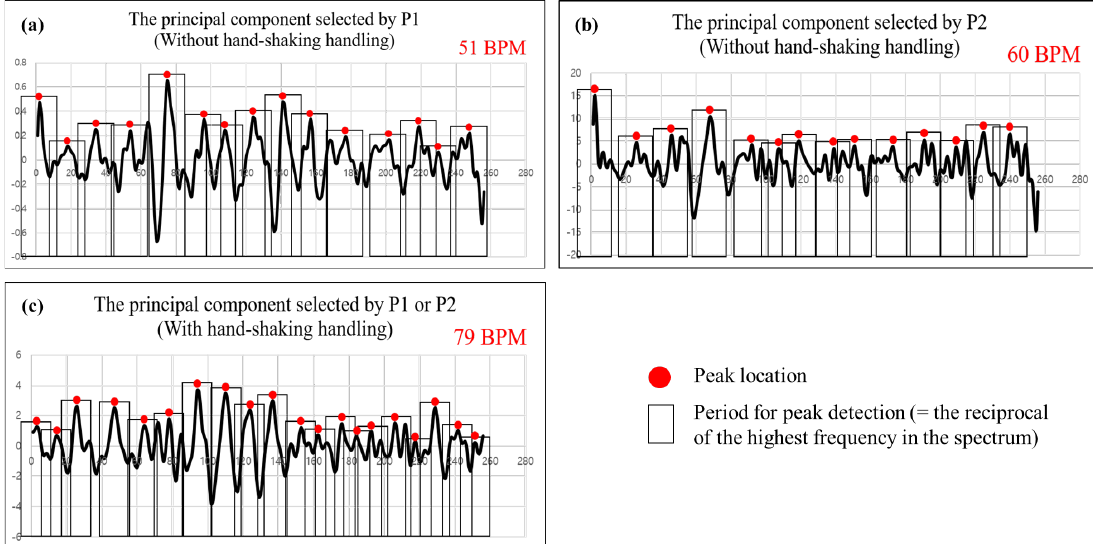
Figure 8. Peak detection and heart-rate computation from the selected principal component signals in Figure 7. In ( a ), ( b ), and ( c ), the peaks were found one by one in periods of 1/0.93 s, 1/1.09 s, and 1/1.4 s,